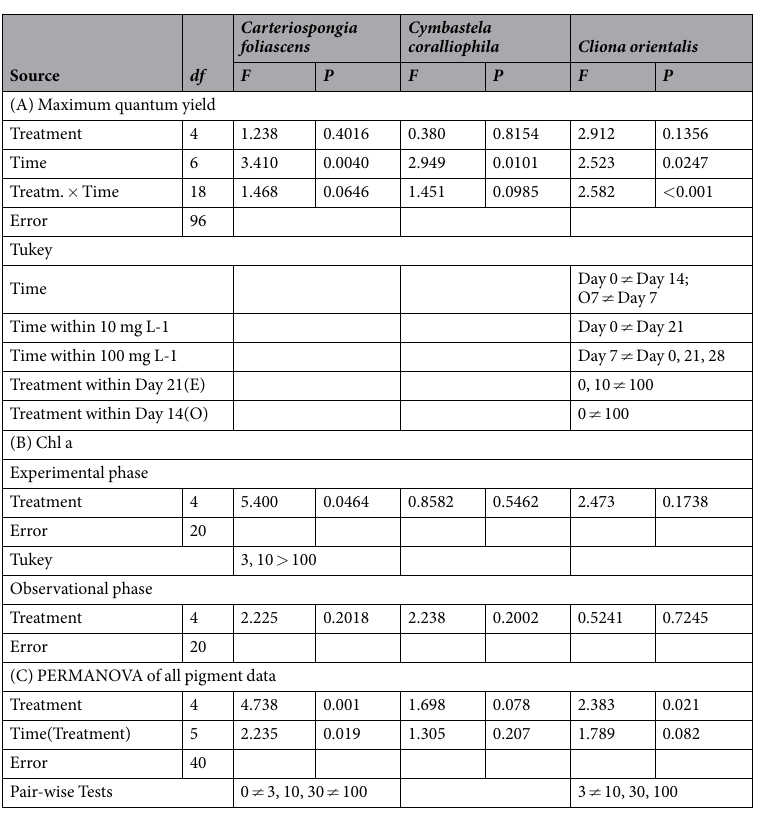
Table 2. ANOVA tables and summaries of linear mixed models on the effects of elevated SSCs on photosymbionts. (A) Effects of treatment and time on maximum quantum yield throughout the experiment (B) Effects of treatment on Chl a concentrations at the end of the experimental (E) and observational (O) periods, and (C) Two-way PERMANOVA of all pigment data (Chl a, b, c, d, Total Chlorophyll and Carotenoids) with SSC and Time as factors, for the three phototrophic species (SSC: 0, 3, 10, 30 and 100 mg L − 1 ). In a-c, Tukey tests were performed for significant pairwise multiple